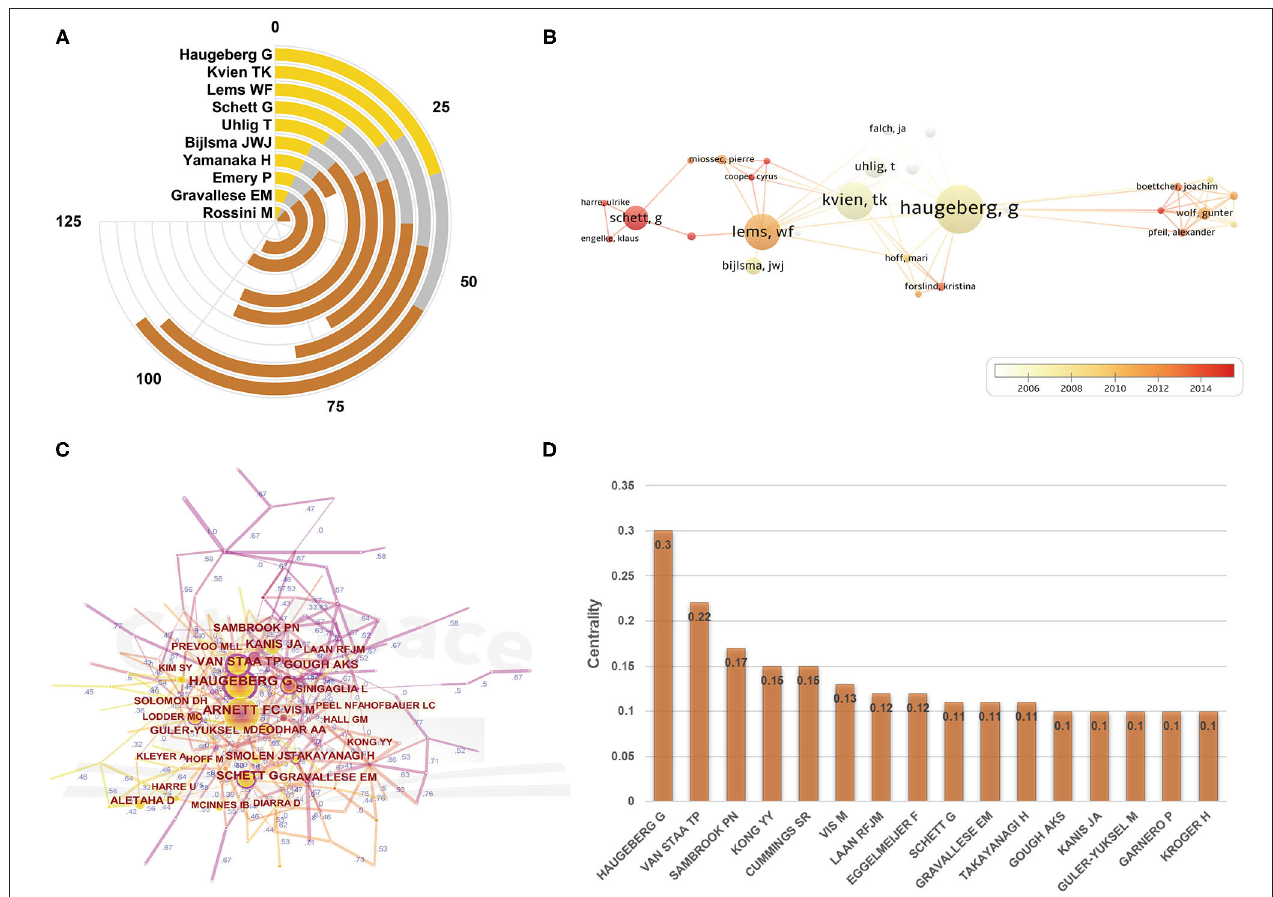
FIGURE 4 | (A) The publication counts, h -index, and ACI of the top 10 most prolific authors. (B) Overlay visualization map of author co-authorship analysis generated by VOSviewer software. (C) Visualization map of author co-citation analysis by using CiteSpace software. (D) All the authors with a centrality value of more than 0.1 (author co-citation